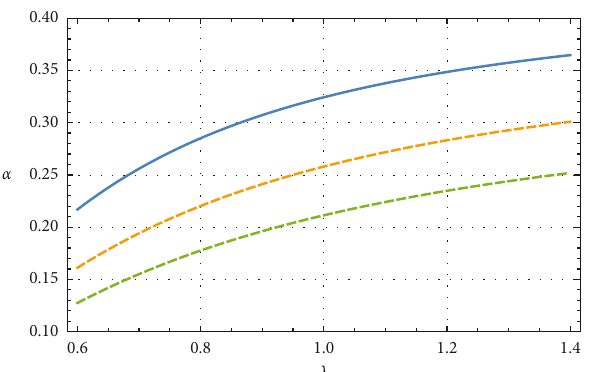
Figure 4: The isotope mass exponent, α , is shown as a function of the coupling constant, λ , using δ values obtained with our model, where δ � ( 1 − c 2 ) E / E . The curves for δ � 0 . 03 , 0 . 06, and 0.1 are F ph plotted from top to